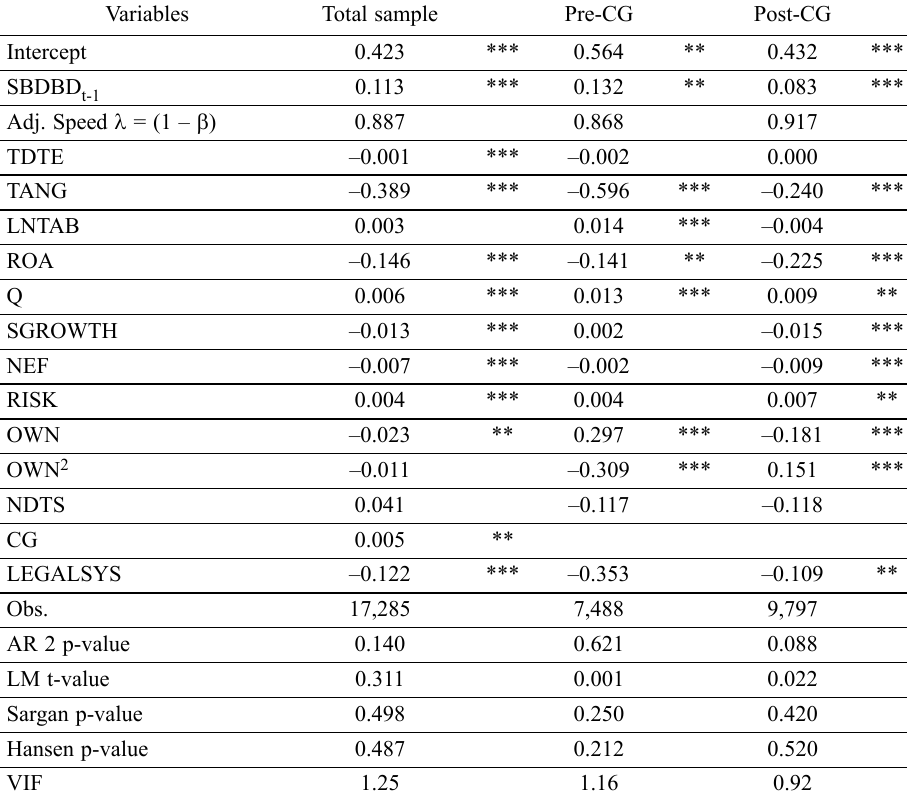
Table 2. Determinants of bank debt maturity for the whole